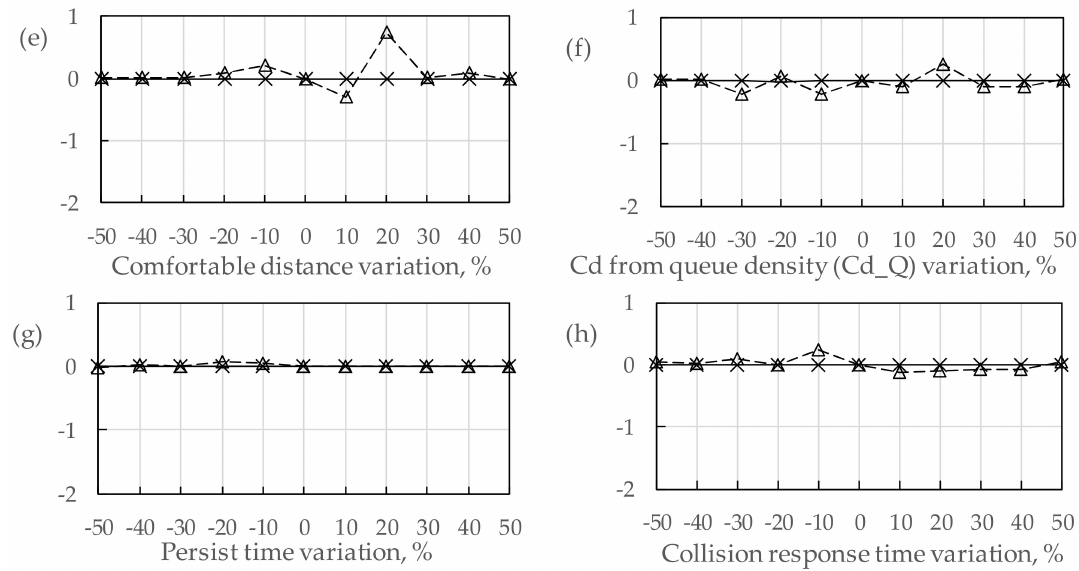
Figure 7. Sensitivity analysis of parameters assessed under two scenarios. ( a )–( h ): The sensitivity analysis results of di ff erent parameters, including walking speed, shoulder width, acceleration time, distance to obstacles, comfortable distance, comfortable distance from queue density, persist time and collision response time.